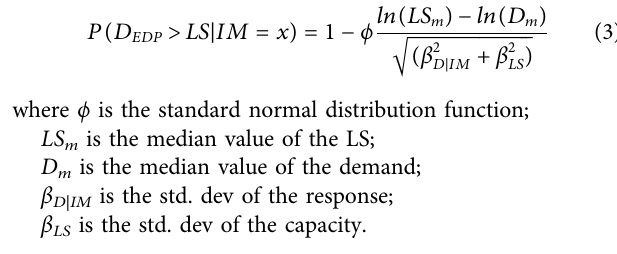
Frontiers in Built Environment |